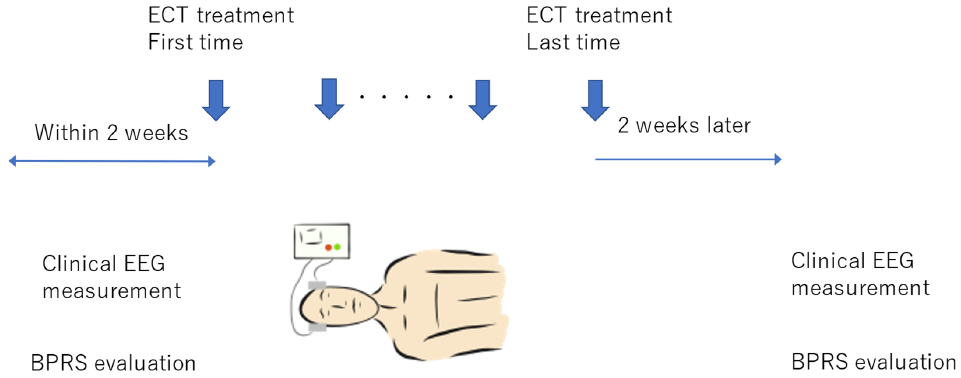
Figure 1. Study flowchart showing the sequence and timing of electroconvulsive therapy (ECT), electroencephalography (EEG), and the Brief Psychiatric Rating Scale (BPRS).